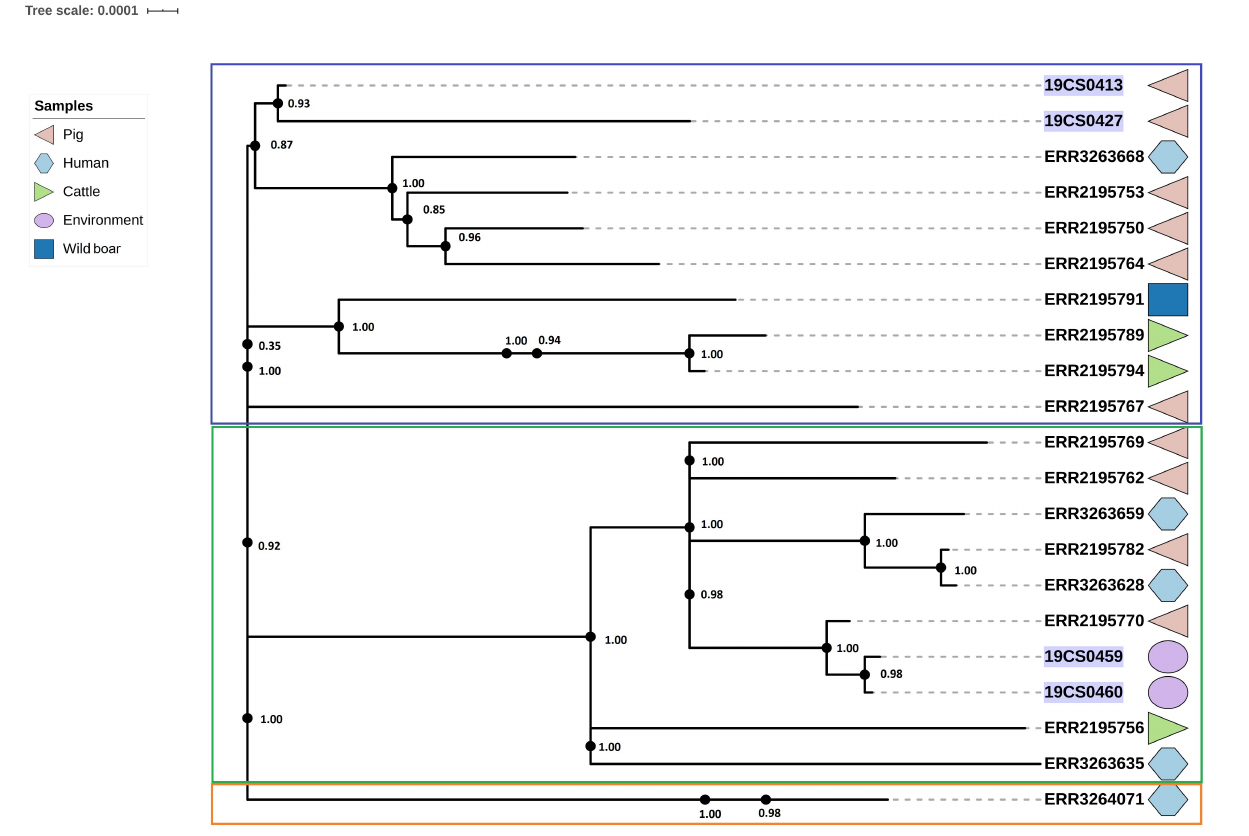
FIGURE 4 | Phylogenetic SNP tree of S. Derby ST40 strains. Clusters are labeled in colored rectangles: cluster 1 (blue), cluster 2 (green) and cluster 3 (orange). The colored zone alongside the tree represents the source of the isolates: pig (pink), human (blue) and cattle (green), environment (purple), and wild type (dark blue). FLI isolates marked in